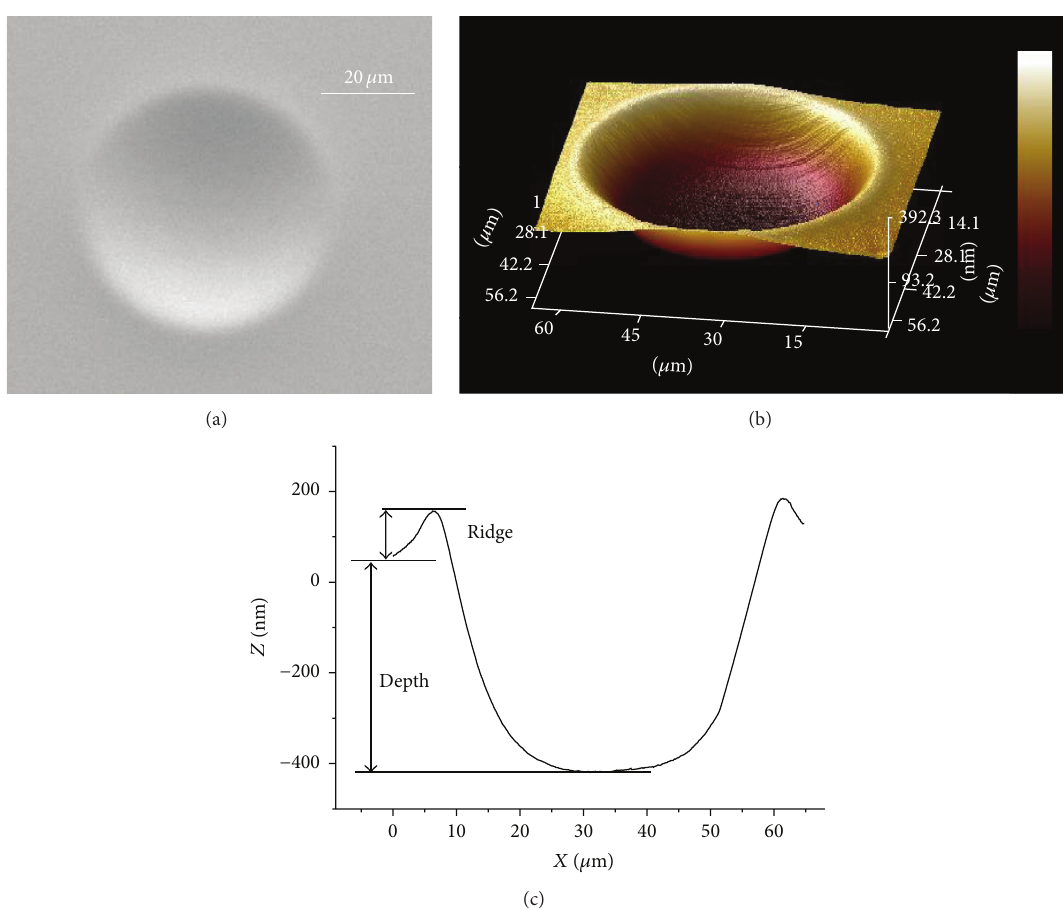
Figure 4: 50 𝜇 m circle in SU-8 2010 after PEB: (a) SEM photograph. (b) AFM. (c) AFM